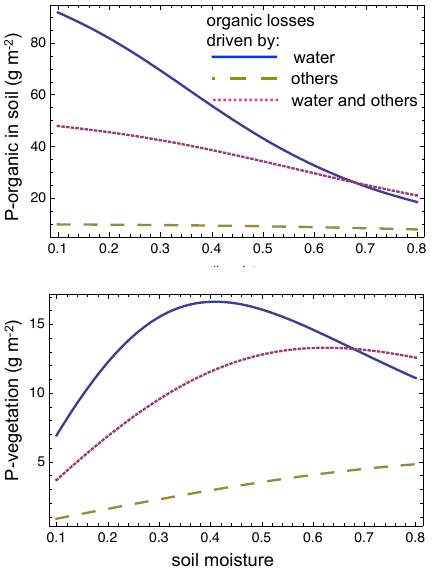
Fig. 3. Sensitivity of organic biomass losses to soil moisture. For ecosystems in steady-state, we compare the effect of soil moisture on three different schemes of P in organic biomass losses ( O o ). The solid line represents ecosystems with organic matter losses that are mainly driven by water. The dashed line presents ecosystems with organic matter losses mainly driven by wind, human biomass re- moval and fires ( k f ) and the dotted line represents ecosystems with losses by both, k f and k r . The panel below illustrates the steady state for P in vegetation Eq. (22) and the panel above represents the P in soil organic biomass Eq. (21). For this simulation we used I d = I w =0.0125gPm − 2 a − 1 and the values in Table